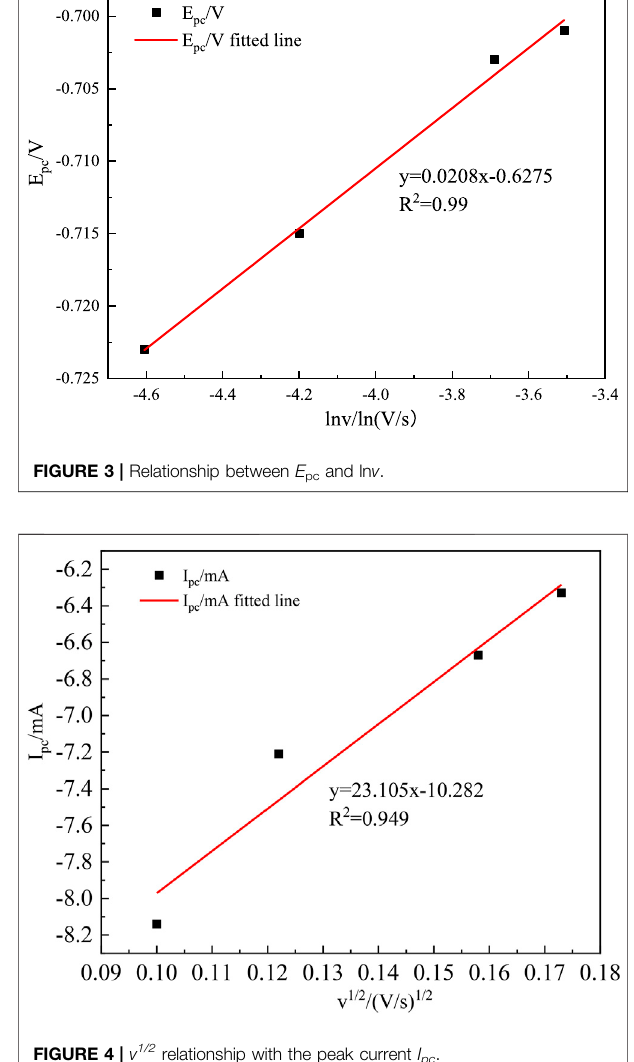
FIGURE 4 | v 1/2 relationship with the peak current I pc .